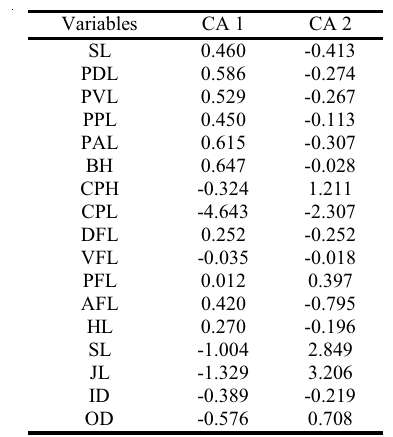
Table 1. Variable morphometric scorers for the canonical axis for Astyanax altiparanae from the upper rio Tibagi and up- per rio Iguaçu samples.